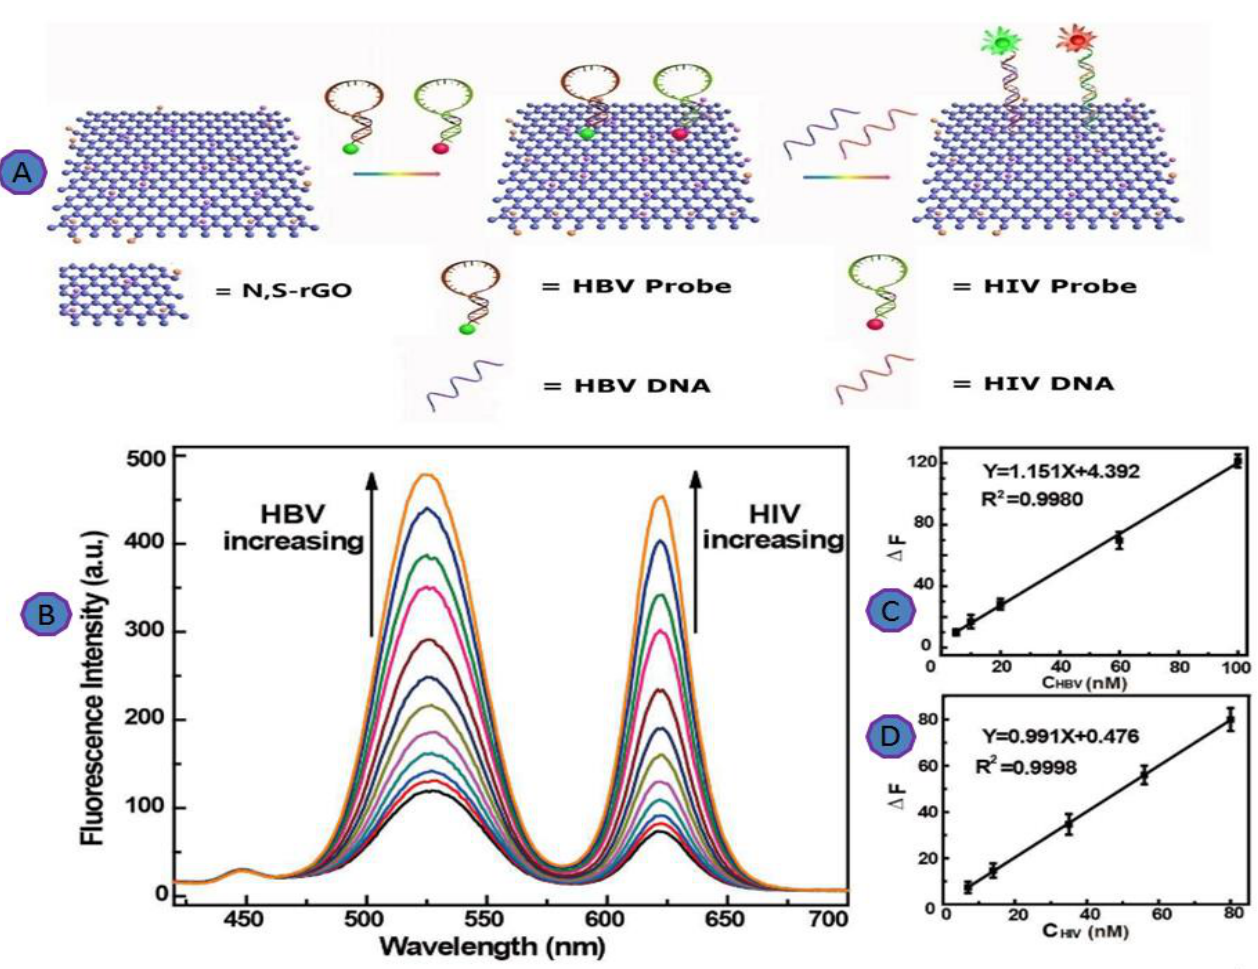
Figure 12. ( A ) Schematic illustration of N, S-rGO for multiplexing detection of HBV and HIV; ( B ) fluorescence spectra of N, S-rGO; ( C ) linear relationship for the detection of HBV DNA; ( D ) linear relationship for the detection of HIV DNA. Reprinted with permission from Ref. [77]. Copyright 2016, American Chemical Society.